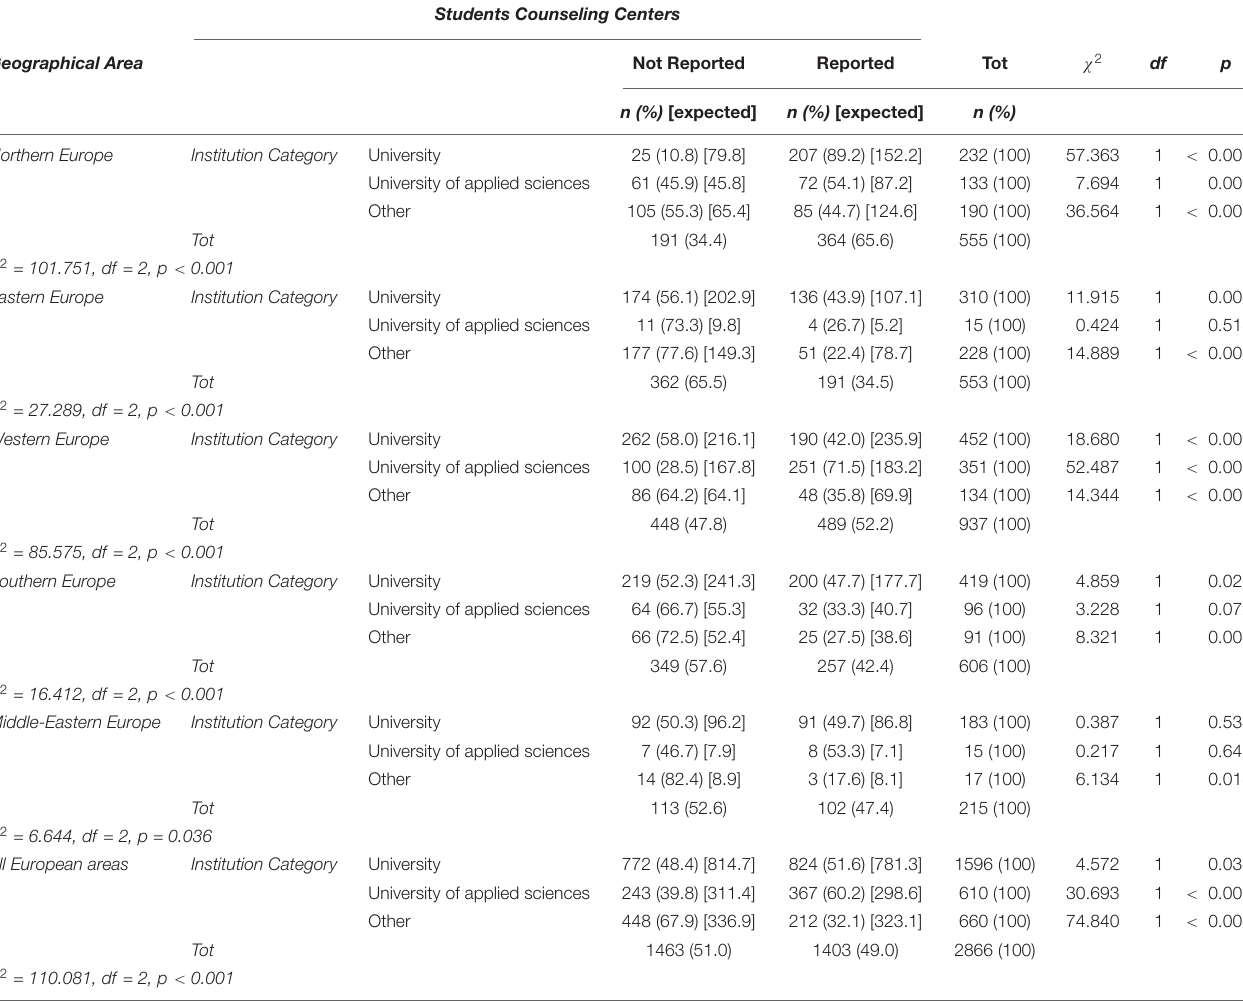
TABLE 6 | Presence of student counseling services in different institution category in each European geographical area. Students Counseling